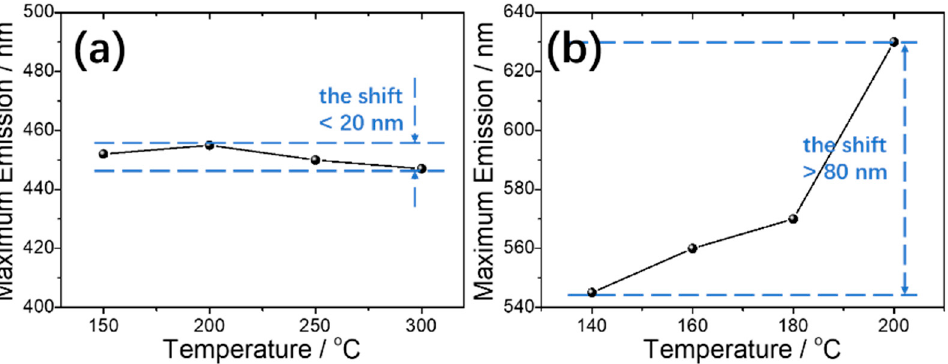
Figure 7. Reaction temperature vs. maximum emission of CDs synthesized from CA by ( a ) hydrothermal and ( b ) solvothermal methods. The data in ( a , b ) are organized according to Ref. [6] and Ref. [63], respectively.